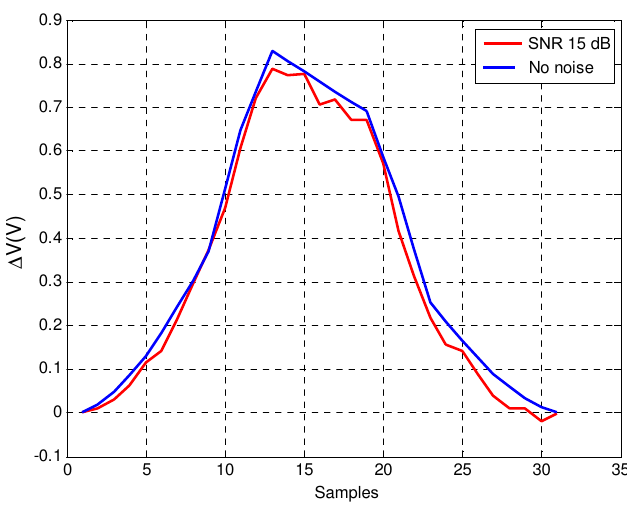
Figure 17. Inductive signature of the detector with synchronous demodulator with and without noise.